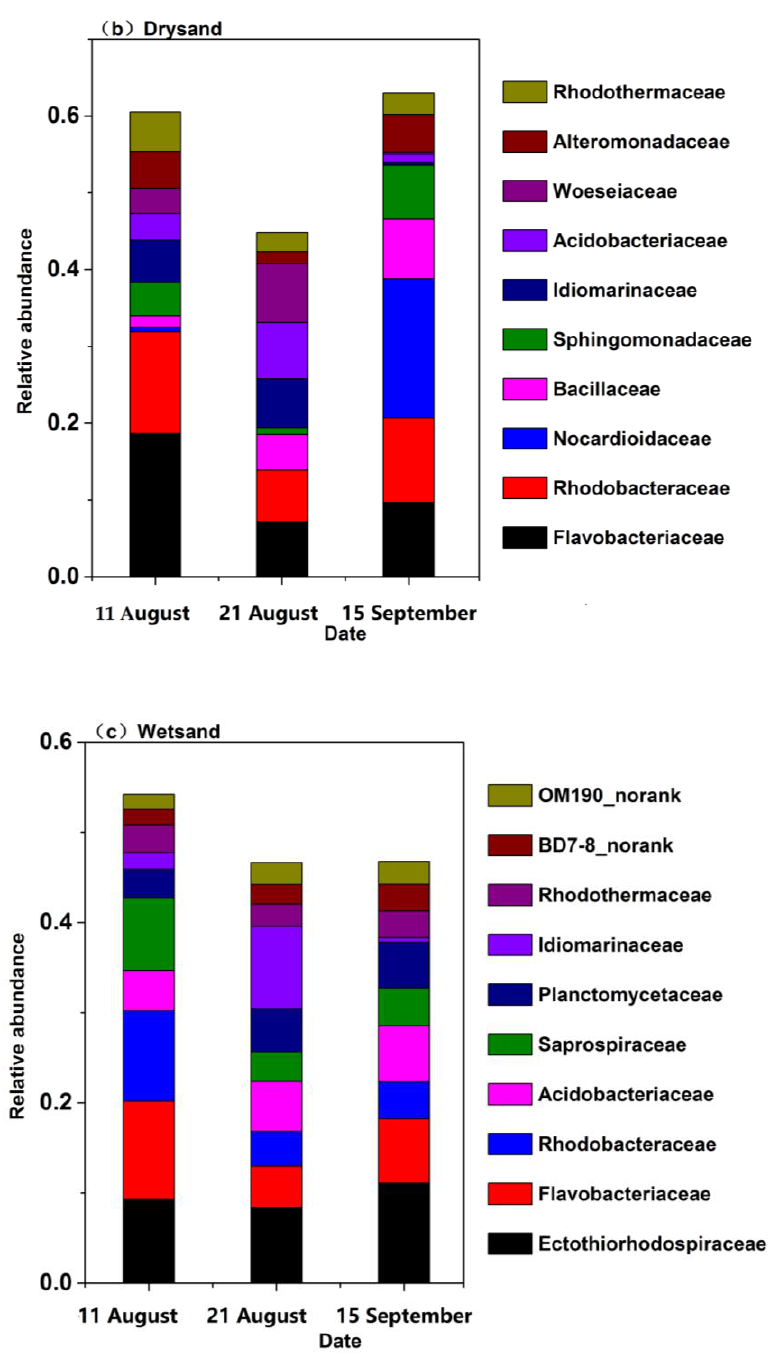
Figure 5. Changes in community structure at the family level (top 10) before and after the typhoon events in seawater ( a ), dry sand ( b ), wet sand ( c ), in which each column represents the parallel of three samples.